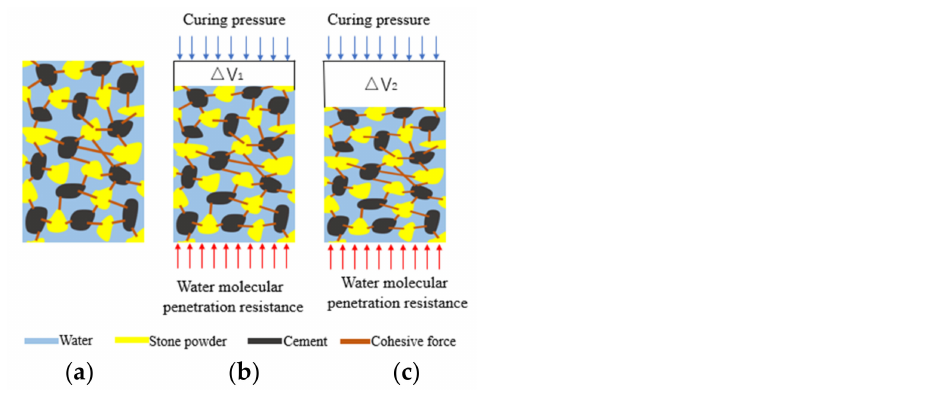
Figure 11. Influencing mechanism of curing pressure on strength of stone powder-cement slurry: ( a ) 4 MPa; ( b ) 4 MPa; ( c ) 8 MPa.